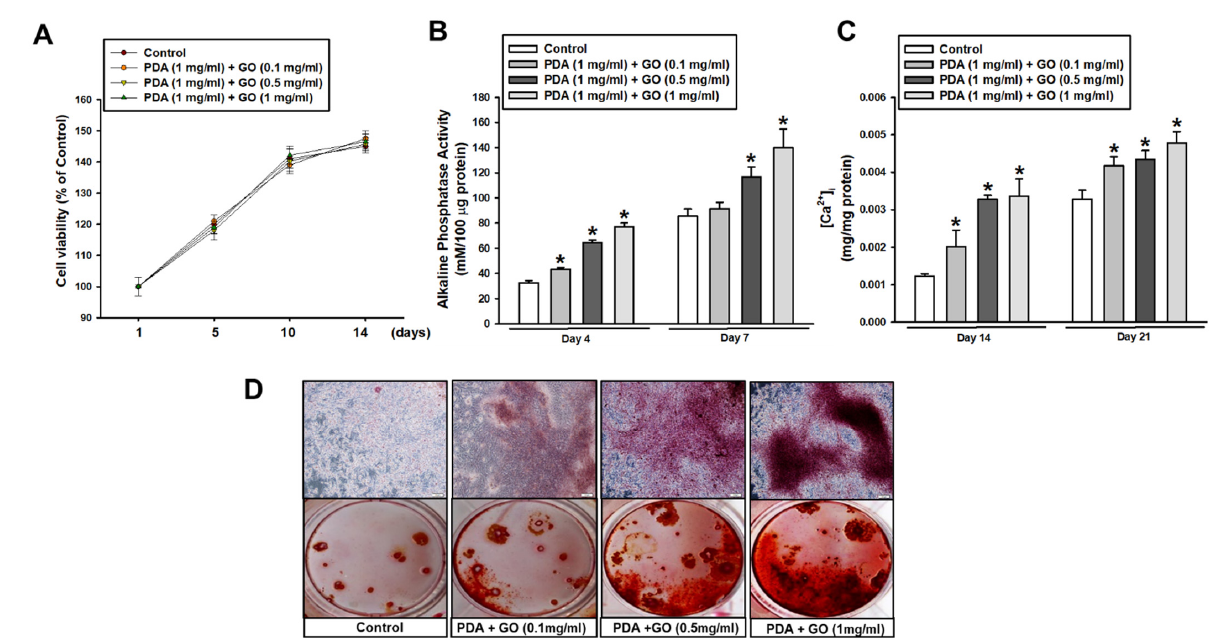
Figure 2. Osteogenic differentiation of ESCs cultured on PDA/GO-modified surfaces. ( A ) Cells were cultured on the PDA/GO substrate (composite of PDA with 1 mg/mL and variable GO concentration with 0.1, 0.5, or 1 mg/mL) for 1, 5, 10, and 14 days, and then, the cell viability was assessed as described in the Materials and Methods. ( B ) ALP activity, ( C ) [Ca 2+ ] i , and ( D ) Alizarin Red S staining were evaluated after 4, 7, 14, or 21 days of osteogenic induction. The values are presented as means ± SD ( n = 3). * p < 0.05 vs. the control value at each time point.